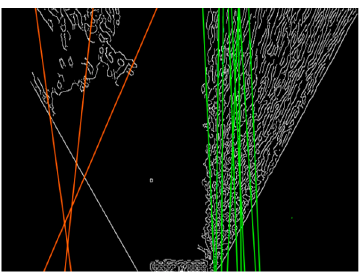
Figure 11. Lines used to compute the metrics. Left lines (orange), high distribution, low confidence. Right lines (green), low distribution, high confidence.